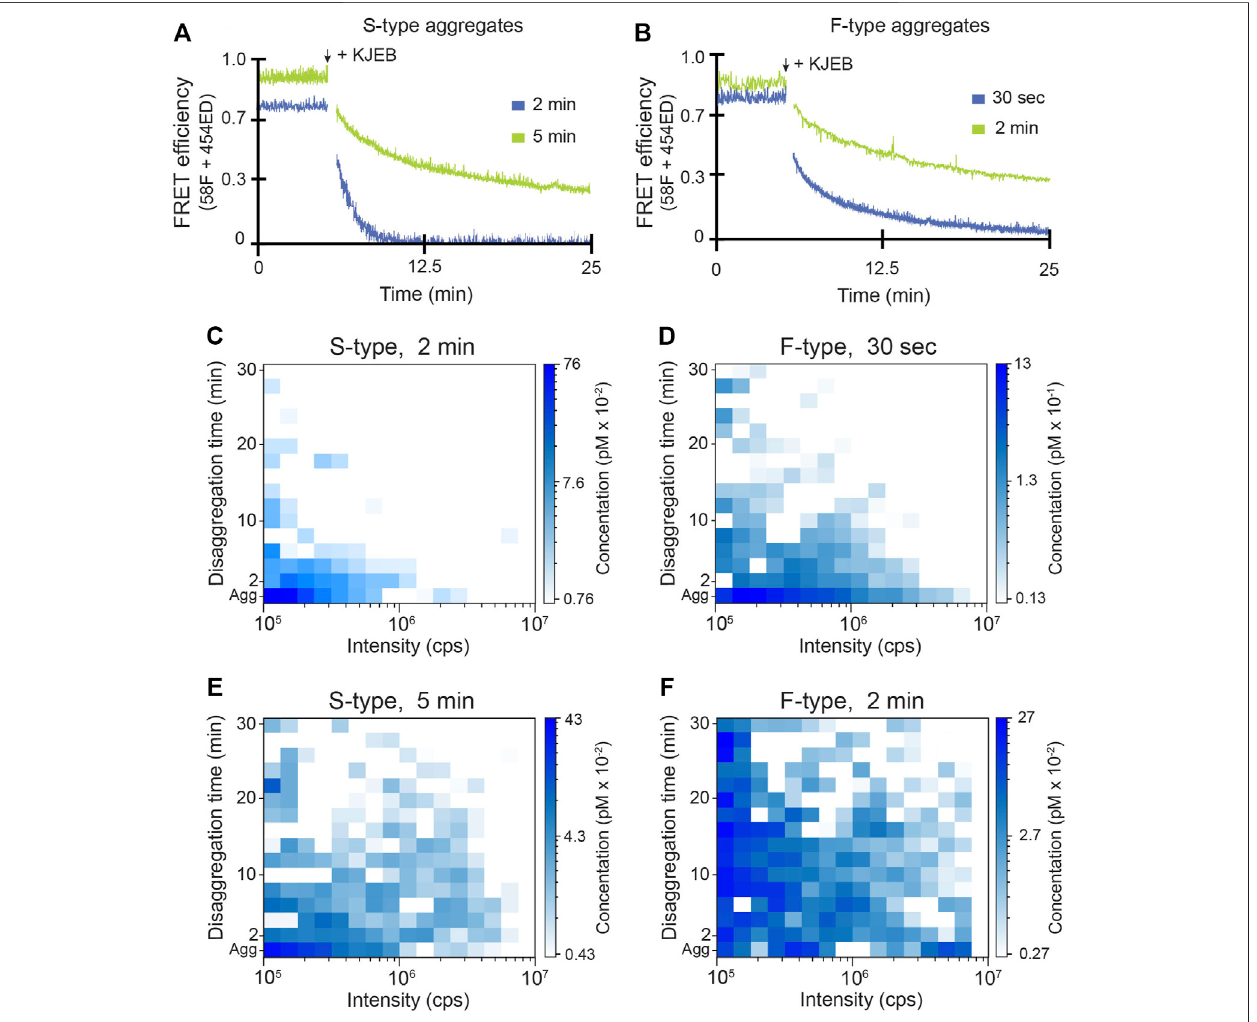
FIGURE4| DisassemblyofRuBisCOaggregatesbythefullKJEBbi-chaperonesystem.ThedisassemblyofS-type (A) andF-type (B) aggregatesbythefull E.coli bi-chaperone system (KJEB) was monitored by inter-molecular FRET at both early (blue) and late (green) aggregation time points. Co-labeled aggregates (10 nM fi nal totalmonomer)werecreated froma1:1mixture of58Fand454EDmonomers,followedbytheaddition of0.5 µM DnaK,1 µMDnaJ,1 µM GrpE,and300 nMClpBplus 2 mM ATP and an ATP regeneration system. Disassembly was monitored in real time using a T-format spectro fl uorometer. The population-resolved kinetics of RuBisCO-TMR aggregate disassembly for S-type and F-type aggregates by the KJEB system was examined by BAS at early (C,D) and late (E,F) aggregation time points. The aggregate particle distributions prior to the addition of KJE are shown ( Agg ). Following addition of KJEB and ATP, aggregate disassembly was monitored in real time, with BAS histograms calculated every 2 min of raw burst data. The histograms shown are a combination of n = 3 independent experimental replicates.